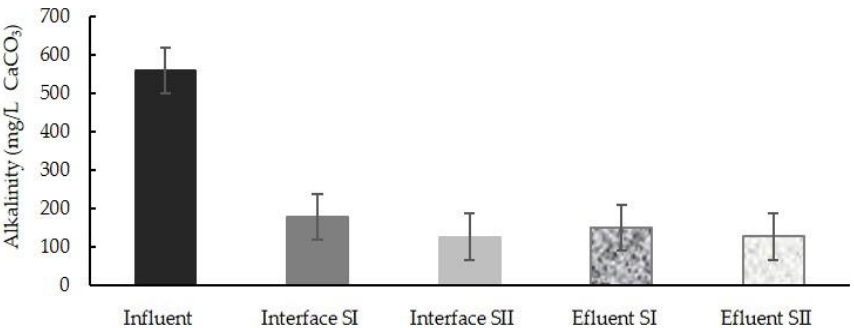
Figure 7. Alkalinity measurements in the two PS VF wetlands.